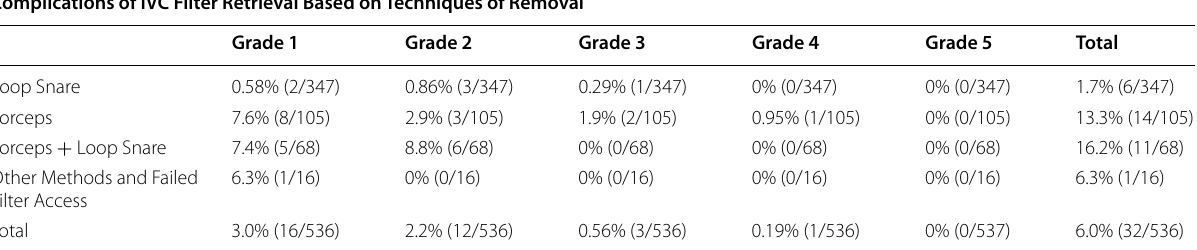
Table 5 Graded complications for each retrieval technique. If multiple complications occurred during a single procedure, then the complication with the highest grade was recorded Complications of IVC Filter Retrieval Based on Techniques of